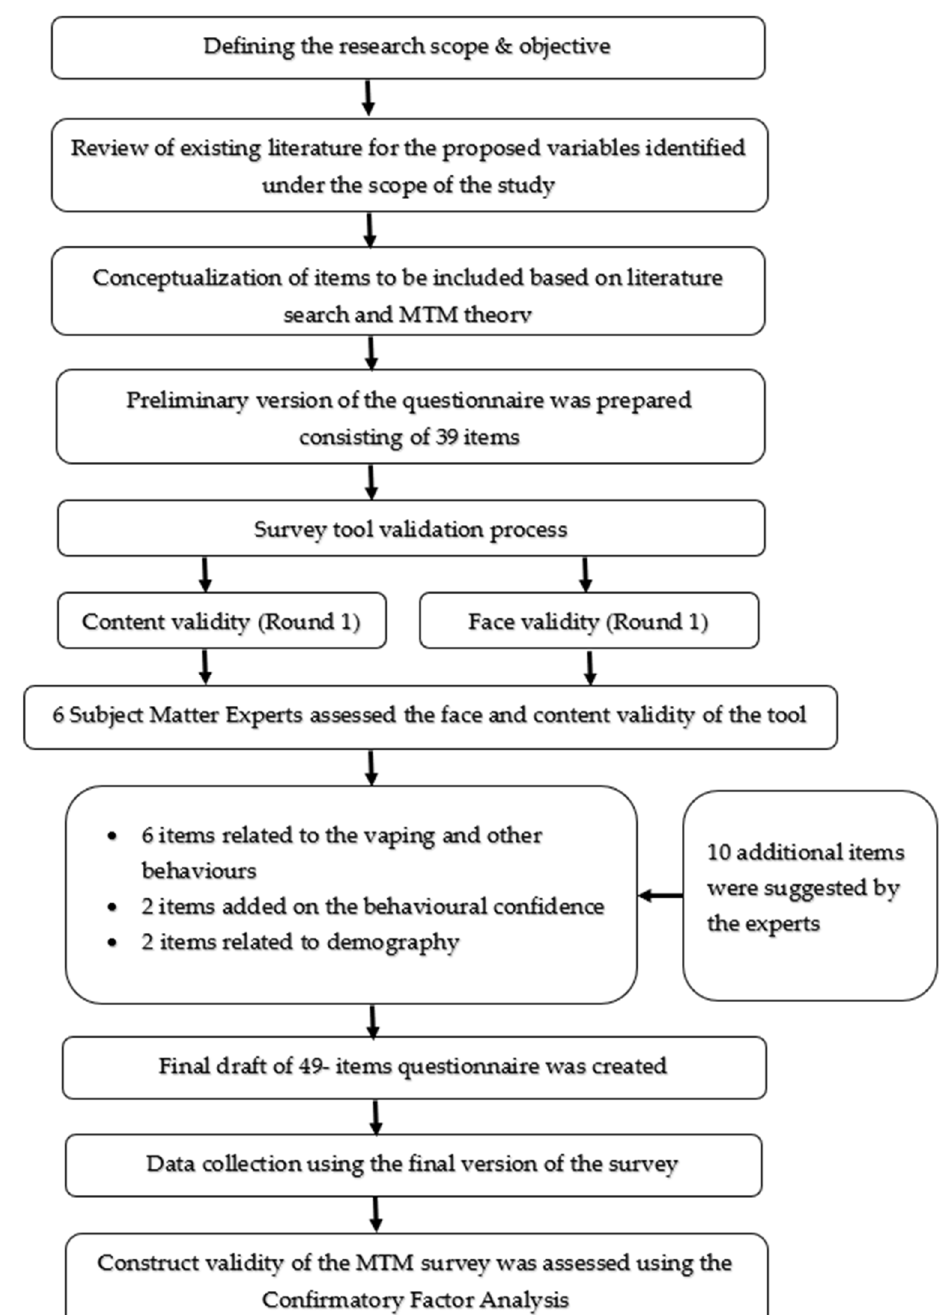
Figure 2. A flow chart depicting the designing and validation of the